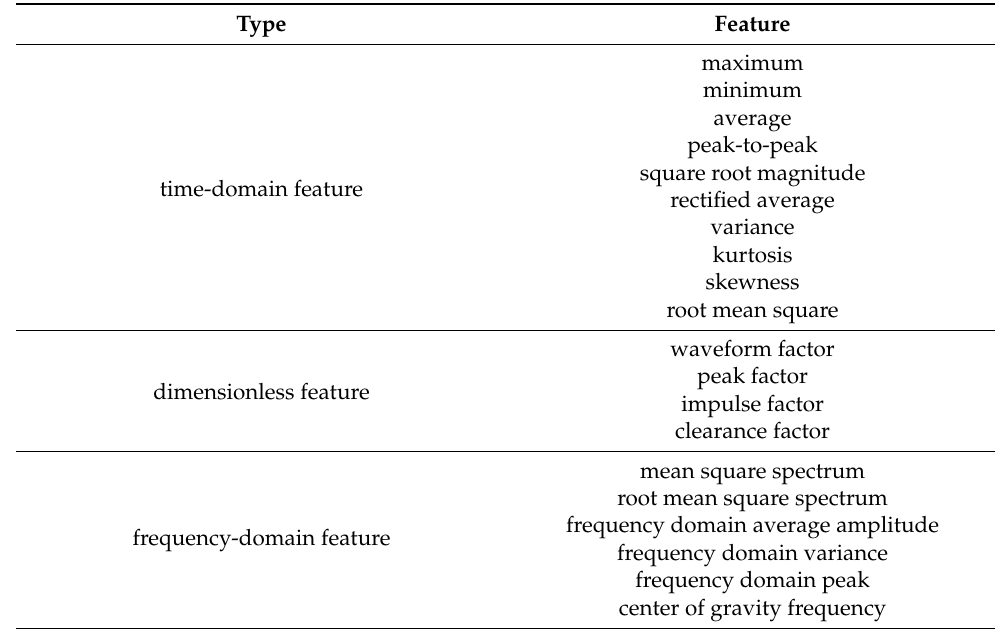
Table 1. Feature extraction of rolling bearing vibration